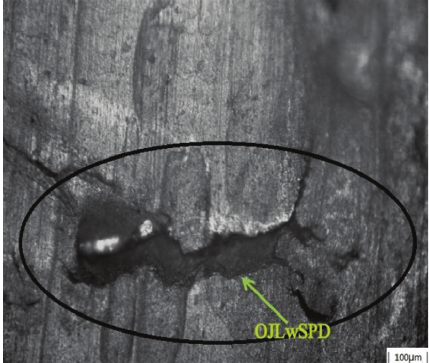
Figure 6: Microstructure of sample 4, underwater welded speci- men joined at 1000 rpm,